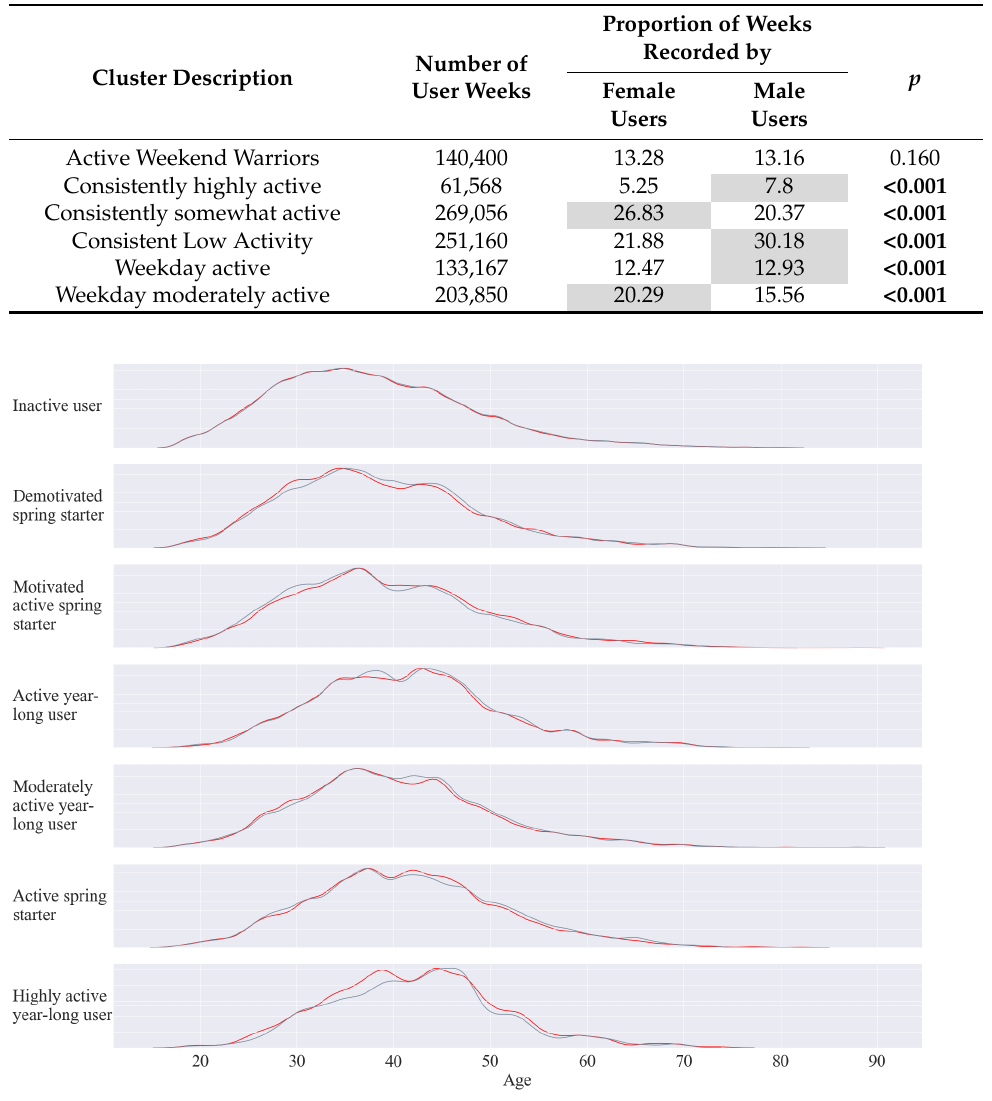
Figure 9. Age distribution of users in yearlong physical activity behaviour clusters (grey: k-means, red: agglomerative